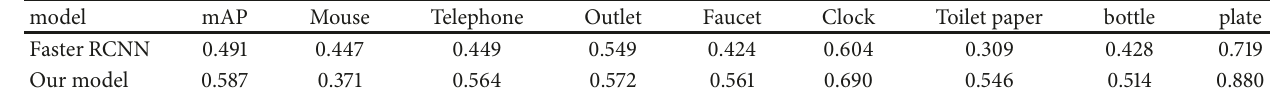
Table 5: The comparison of accuracy between our model and Faster-RCNN